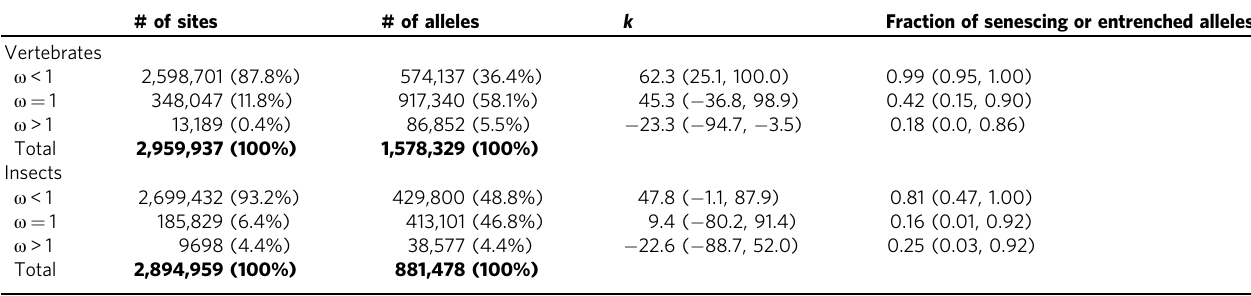
Table 1 Senescence and entrenchment in evolution of genomes of vertebrates and insects. # of sites # of alleles k Fraction of senescing or entrenched alleles